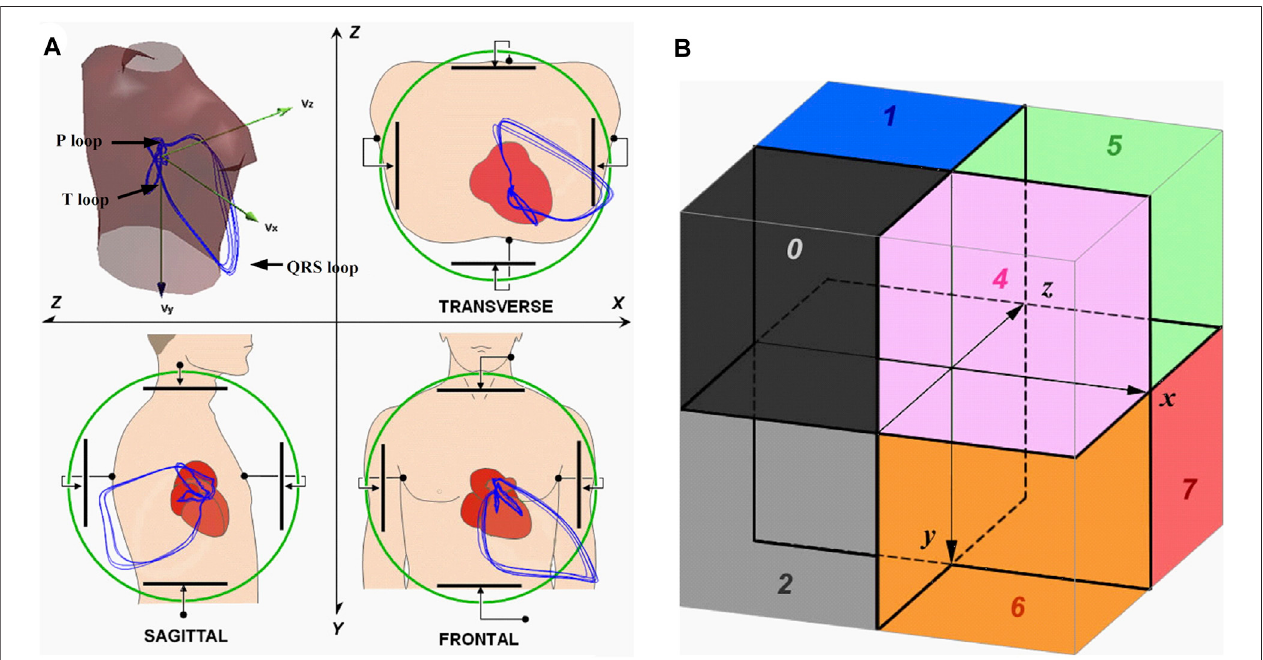
FIGURE 4 | (A) Acquiring VCG signals; (B) Locations of the eight octants Yang et al.